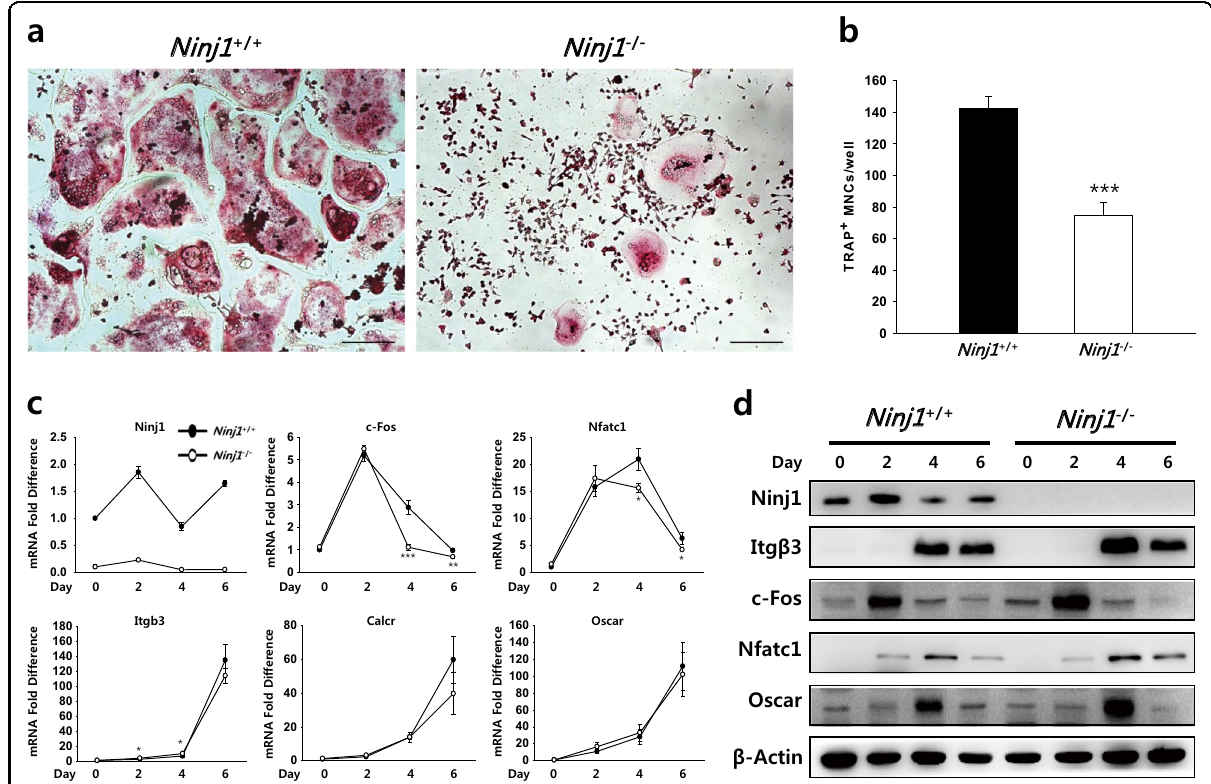
Fig. 2 Ninj1 de fi ciency reduces multinucleated osteoclasts, which is not related to defective differentiation. a , b WT and Ninj1 − / − bone marrow cells were cultured with M-CSF for 3 days, and nonadherent cells were discarded. Adherent cells were continuously cultured with M-CSF and RANKL for 7 additional days and subjected to TRAP activity staining. a Representative images of TRAP activity staining. Scale bars, 200 μ m. b Quantitation of TRAP-positive multinucleated osteoclasts. Numbers of TRAP-positive multinucleated osteoclasts (TRAP + MNCs, ≥ 3 nuclei) are shown as the mean ± SD; *** P < 0.001. c , d The expression of Ninj1 and osteoclast markers during osteoclastogenesis was analyzed by quantitative RT-PCR ( c ) or immunoblot assays ( d ). c The mRNA expression of Ninj1 and osteoclast markers, including Nfatc1 , c-Fos , Itgb3 , Oscar , and Calcr , was analyzed, and relative mRNA expression levels are shown as the mean ± SD; * P < 0.05, ** P < 0.01, and *** P < 0.001. d Protein expression of Ninj1 and osteoclast